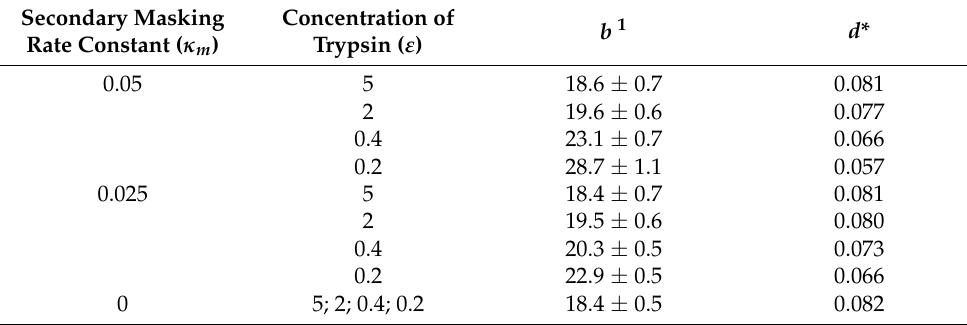
Table 2. Simulation parameters for the modeling of total